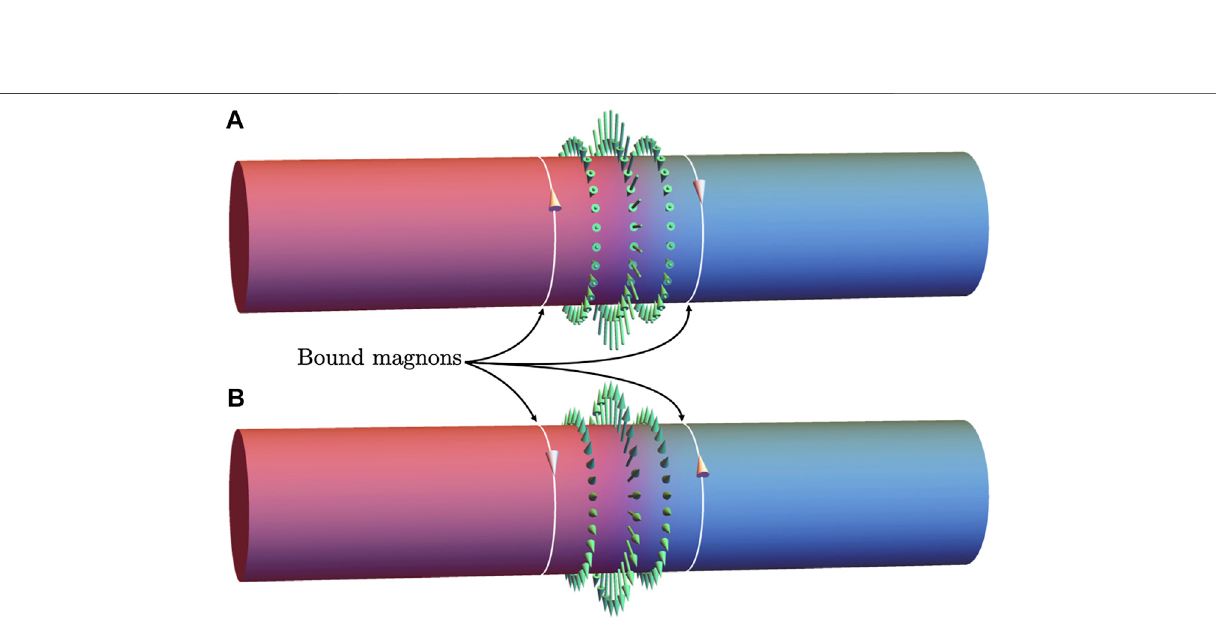
FIGURE 4 | Bound magnon modes on the Skyrmion-textured domain walls whose Skyrmion charges are (A) Q = 1 and (B) Q = − 1. The red and blue regions represent the domains whose background magnetizations are m 0 (cid:1) − ^ z and m 0 (cid:1) ^ z , respectively. White lines represent the bound modes and green arrows represent the emergent magnetic fi